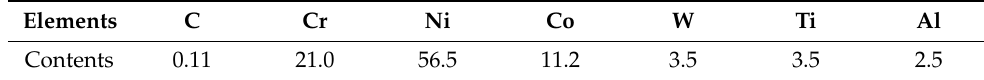
Table 2. The main constituent elements and contents of K452 alloy